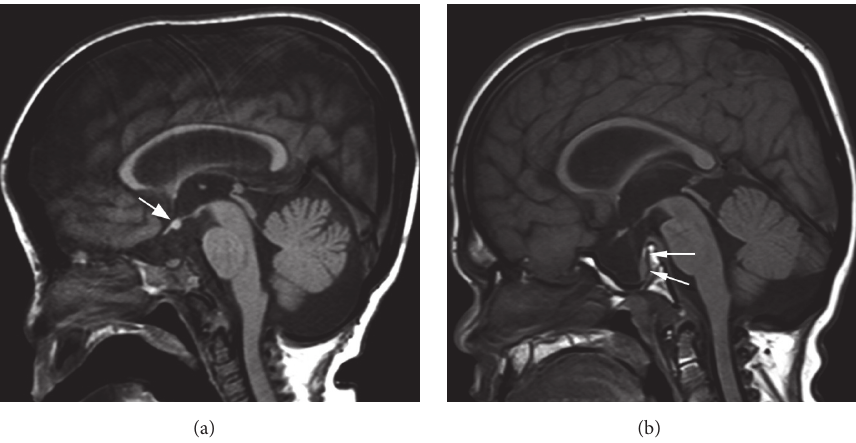
Figure 1: (a) Cranial MRI of Case 1 obtained at the age of 8 years reveals ectopic posterior pituitary lobe. Sagittal spin-echo T1-weighted image shows an abnormal, shallow sella turcica, as well as hypoplastic clivus. A normal T1-hyperintense posterior lobe of the pituitary gland is not identified in the sella turcica. Instead, a T1-hyperintense round structure (arrow) is noted inferior to the floor of third ventricle at the level of infundibular recess. A pituitary stalk is not seen. Prominent forehead related to macrocephaly is also noted. (b) Cranial MRI of Case 2 obtained at the age of 12 years reveals a large empty sella. Sagittal spin-echo T1-weighted image shows a markedly enlarged sella turcica filled with CSF. The anterior and posterior lobes of the pituitary gland (arrows) are displaced posteriorly. A hypoplastic clivus and prominent forehead are present.